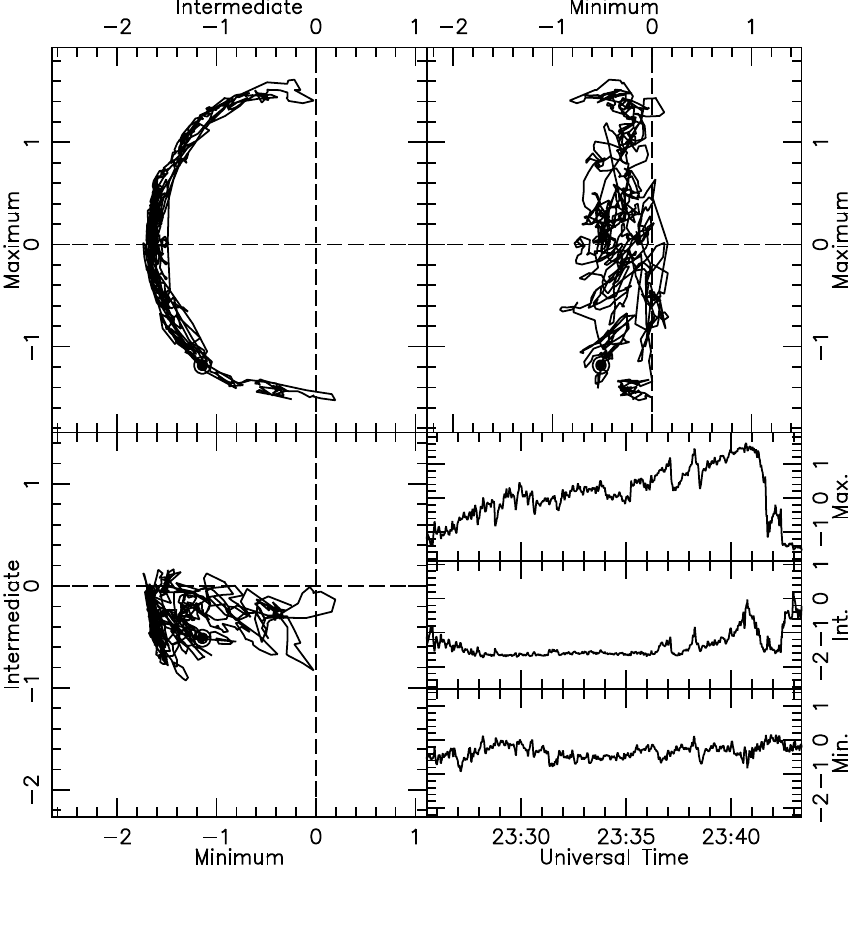
Fig. 8. Variance results for Ulysses event seen at 2.0AU and 80.2 ◦ northern heliographic latitude on 29 July 1995. The event was first discussed and analyzed by Tsurutani et al. (1997). Format is the same as in Fig. 1. Resolution is 1sample/s. The MVAB eigenvectors, expressed in terms of their RTN components, and the corresponding variances are: ˆ x 1 = ( − 0 . 718 ; 0 . 058 ; 0 . 693 ) with λ 1 = 0 . 0378nT 2 ; ˆ x 2 = ( − 0 . 676 ;− 0 . 293 ;− 0 . 676 ) with λ 2 = 0 . 129nT 2 ; ˆ x 3 = ( 0 . 164 ;− 0 . 954 ; 0 . 250 ) with λ 3 = 0 . 578nT 2 . In the bottom right panel, note that the slow rotation precedes the fast rotation for this